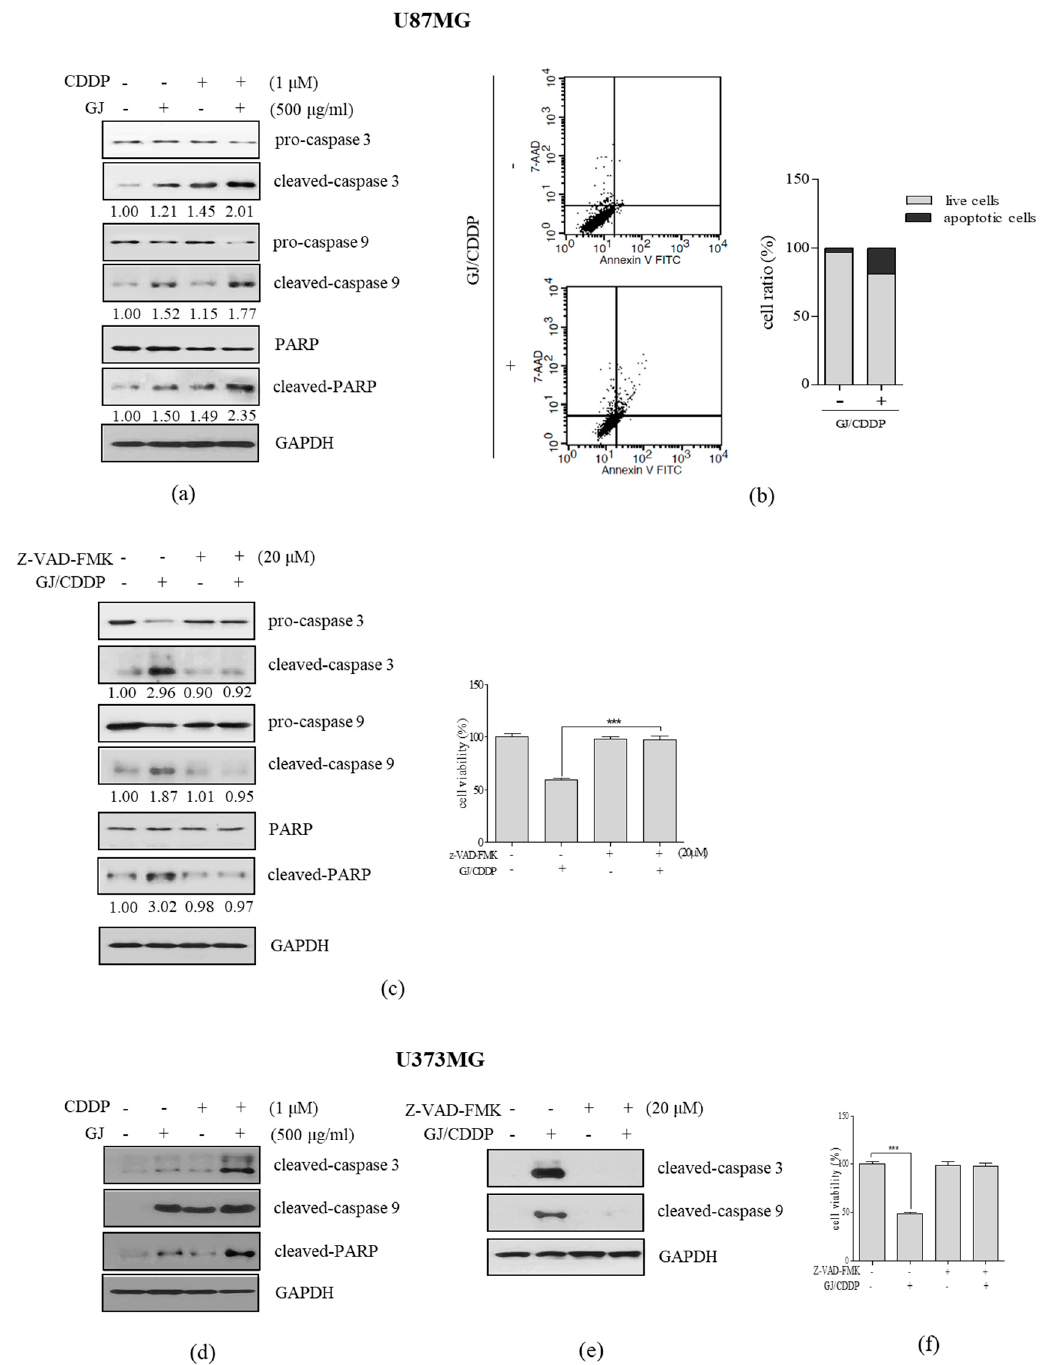
Figure 3. E ff ect of GJ / CDDP combination on apoptosis factors in U87MG and U373MG cells. ( a ) Western blot assays on cleaved caspase-3, cleaved caspase-9, and cleaved PARP were performed in GJ / CDDP combination-treated U87MG cells. ( b ) Annexin V assay was performed in GJ / CDDP combination-treated U87MG cells. ( c ) An MTT assay was performed in GJ / CDDP combination-treated U87MG cells after pre-treatment with Z-VAD-FMK. ( d ) Western blot assays on cleaved caspase-3, cleaved caspase-9, and cleaved PARP were performed in GJ / CDDP combination-treated U373MG cells. ( e , f ) An MTT assay was performed in GJ / CDDP combination-treated U373MG cells after pre-treatment with Z-VAD-FMK. Results are displayed as mean ± S.E. of three or more separate experiments. GAPDH was used as endogenous control. *** p < 0.005 vs. untreated cells. GJ, Gardenia jasminoides ; CDDP,